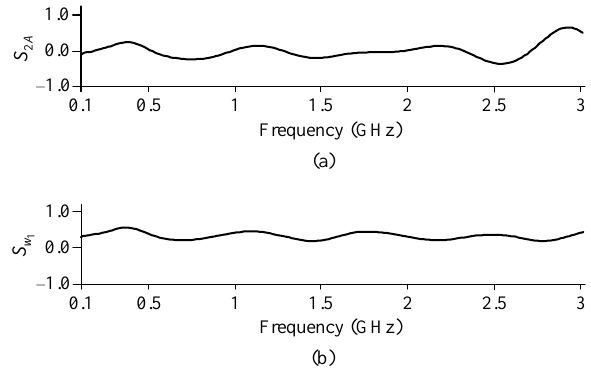
Fig. 8. Impact coefficients on the input impedance of a system when changing: (a) the length 2 A of meander conductor; (b) the width w 1 of meander conductor.